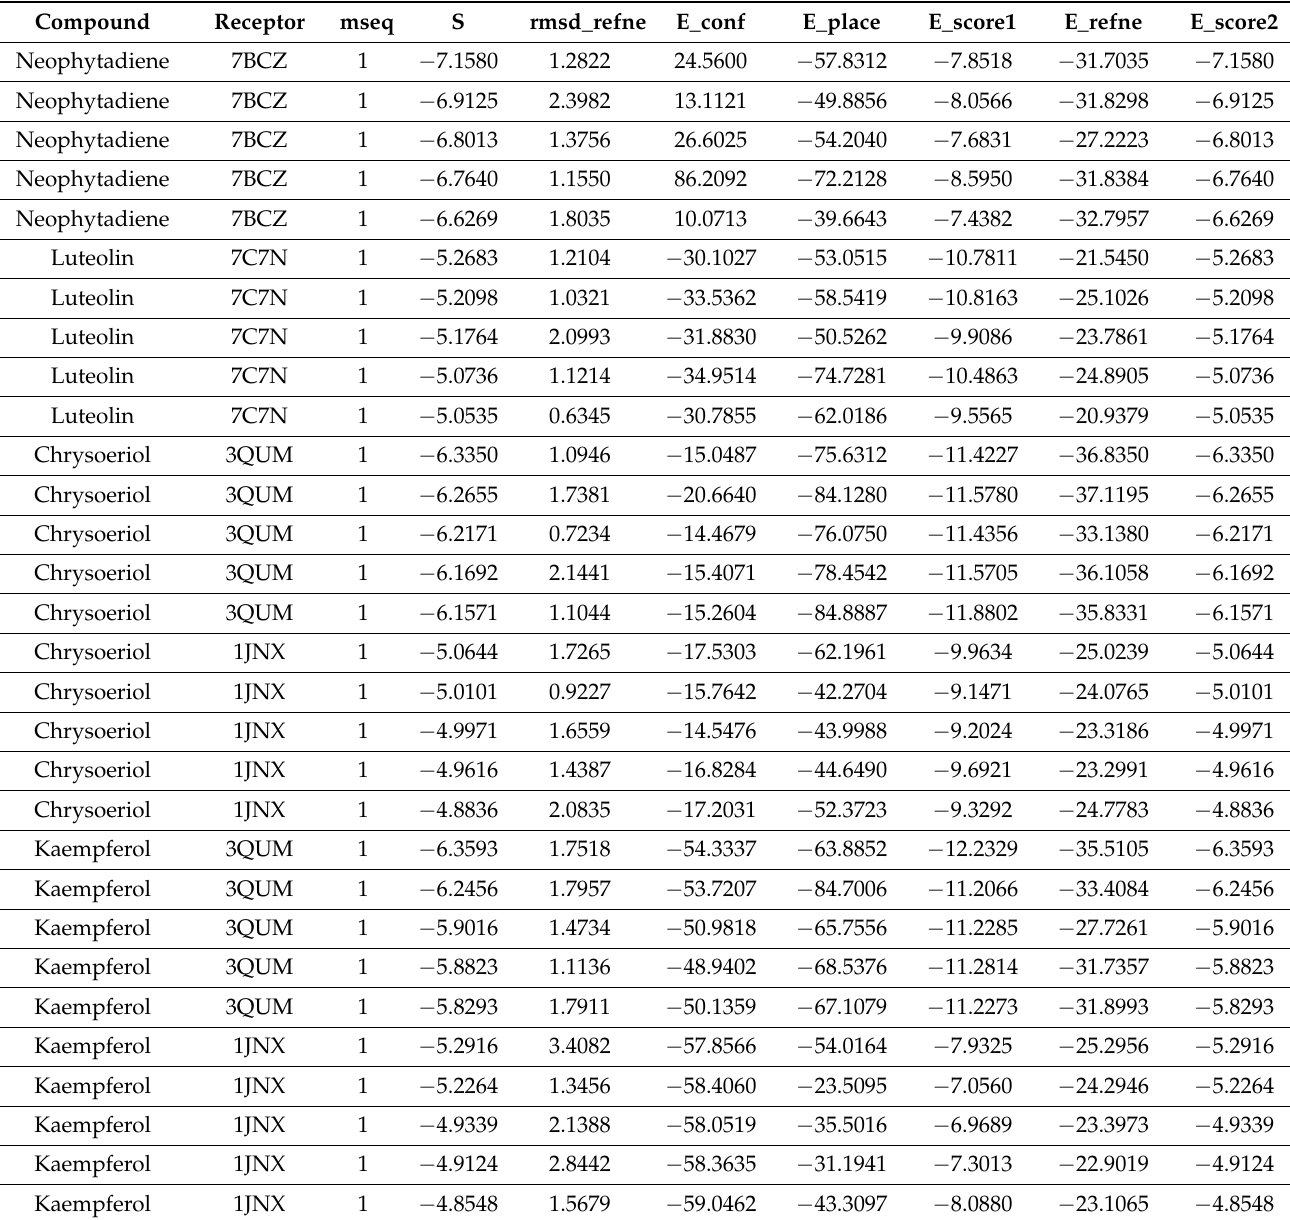
Table 7. Docking scores and energies of compounds with 7BCZ, 7C7N, 3QUM, and 1JNX